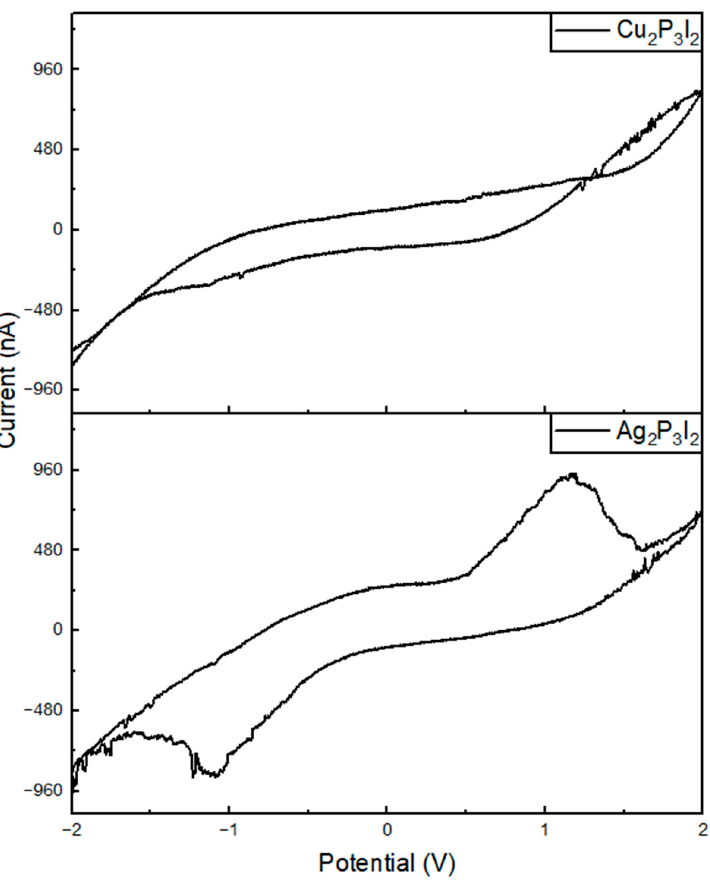
Figure 4. Cyclic IV curves for Cu 2 P 3 I 2 produced by chemical vapor transport ( top ), and Ag 2 P 3 I 2 produced by post-synthetic modification of Cu 2 P 3 I 2 ( bottom ).